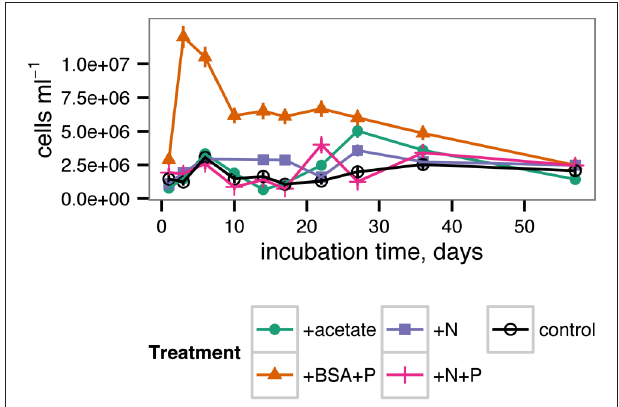
FIGURE 4 | Cell abundance during the incubation. Error bars represent standard error of cell